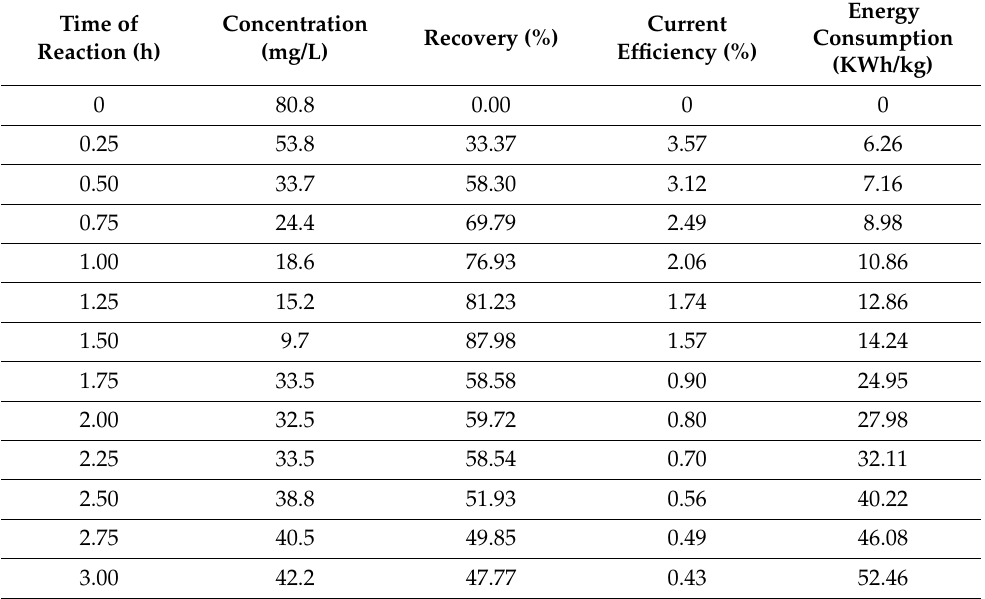
Table 7. Data on Ag recovery by electrowinning with Cu cathode and graphite anode. Time of Reaction